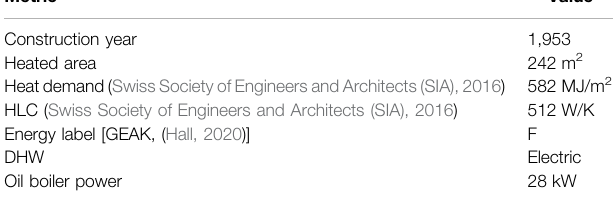
TABLE 2 | Overview of the case study building properties.